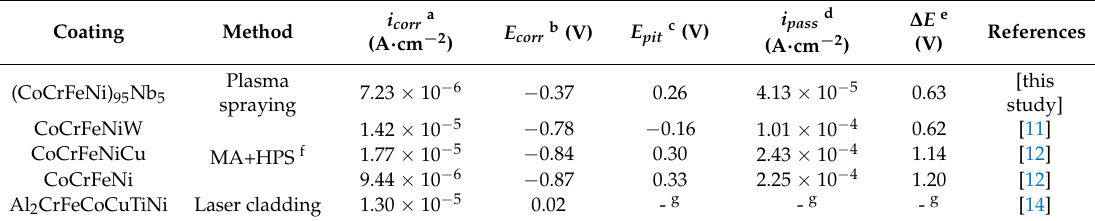
Table 2. Corrosion dynamics parameters of different HEA coatings in 3.5 wt.% NaCl solution.